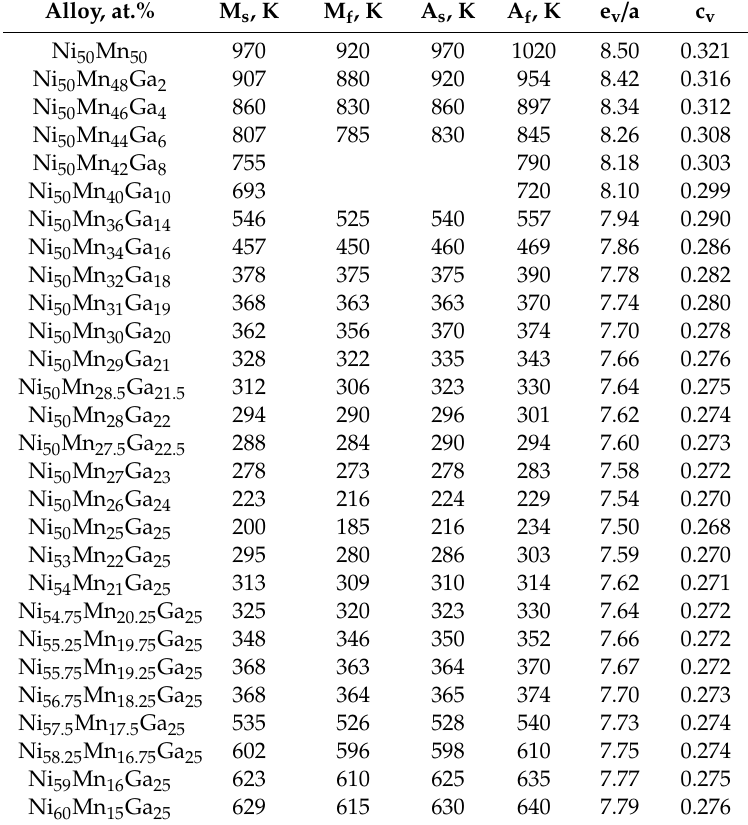
Table 3. Chemical composition, temperatures of TMTs L2 1 ↔ 2M (14M), the number of valence electrons per atom e v / a and their concentration c v of Ni–Mn–Ga-based alloys. Alloy, at.%